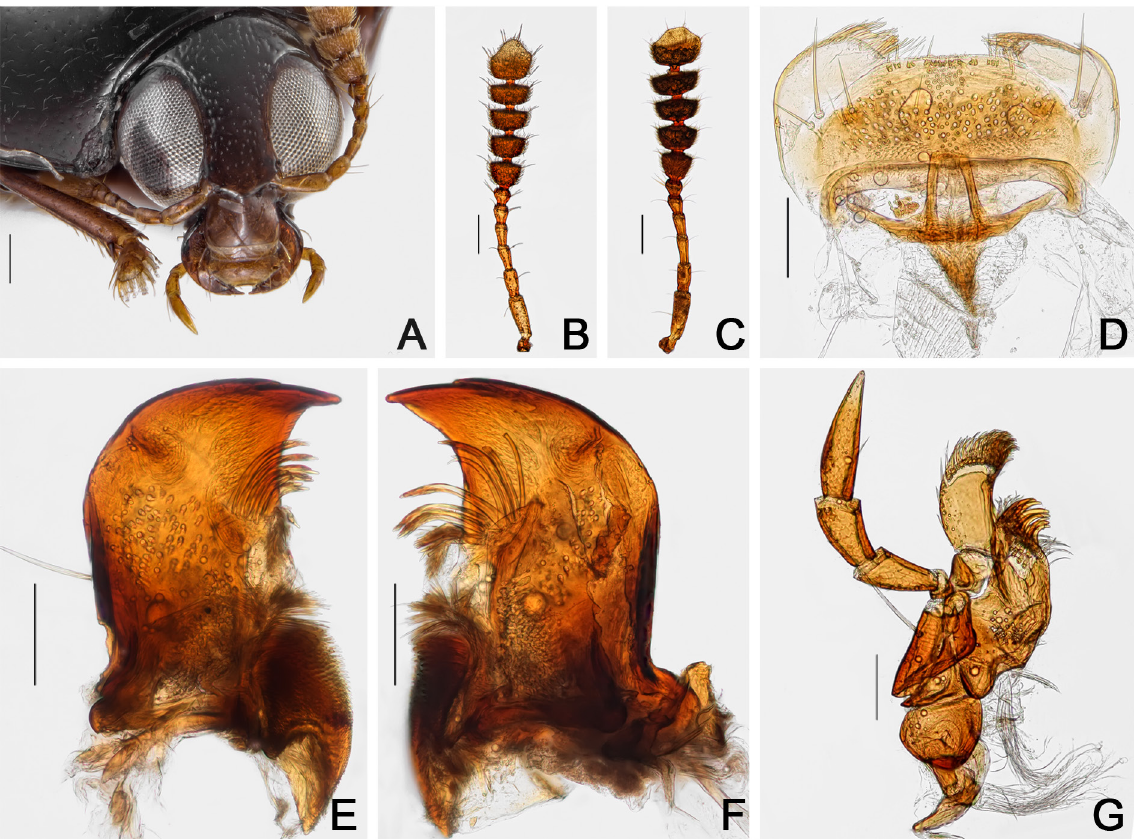
Fig. 39. Cyparium pici sp. nov. A . Holotype, ♂ (CEMT), frontal view. B–G . Paratypes (CELC). B . Male, antenna. C . Female antenna. D . Labrum. E . Left mandible. F . Right mandible. G . Maxilla. Specimens collected at Cotriguaçu (MT, Brazil). Scale bars: A–C = 0.2 mm; D–G = 0.1